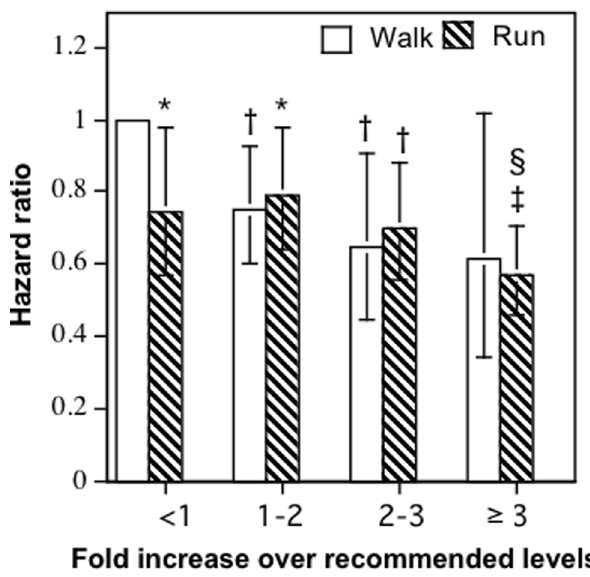
Figure 2. Reduction in the risks for incident cardiac arrhyth- mias per METhr/d energy expended by walking and running separately relative to the least active walkers. Energy expendi- ture (X-axis) is categorized in terms of the upper limit of the minimum recommended physical activity levels (750 MET ? min/wk=1.8 METhr/d [10,18]), e.g., 1 to 2-fold higher activity covers from 1.8 to 3.6 METhr/d, etc. Error bars represent 95% confidence intervals. Significant levels relative to the least active walkers coded: * P , 0.05; { P , 0.01, and ` P , 0.0001. The superscript 1 means that the risk for runners who ran $ 3-fold was significantly less than those who ran , 1-fold the recommended level (P , 0.05).